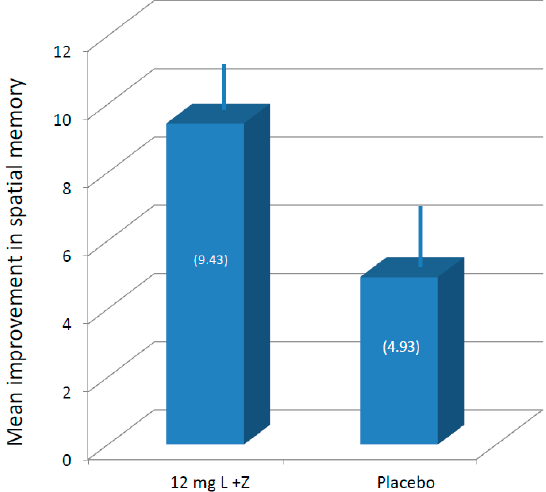
Figure 2. Average (with standard error of the mean, SEM) improvement in spatial memory following one-year supplementation. L, lutein; Z,